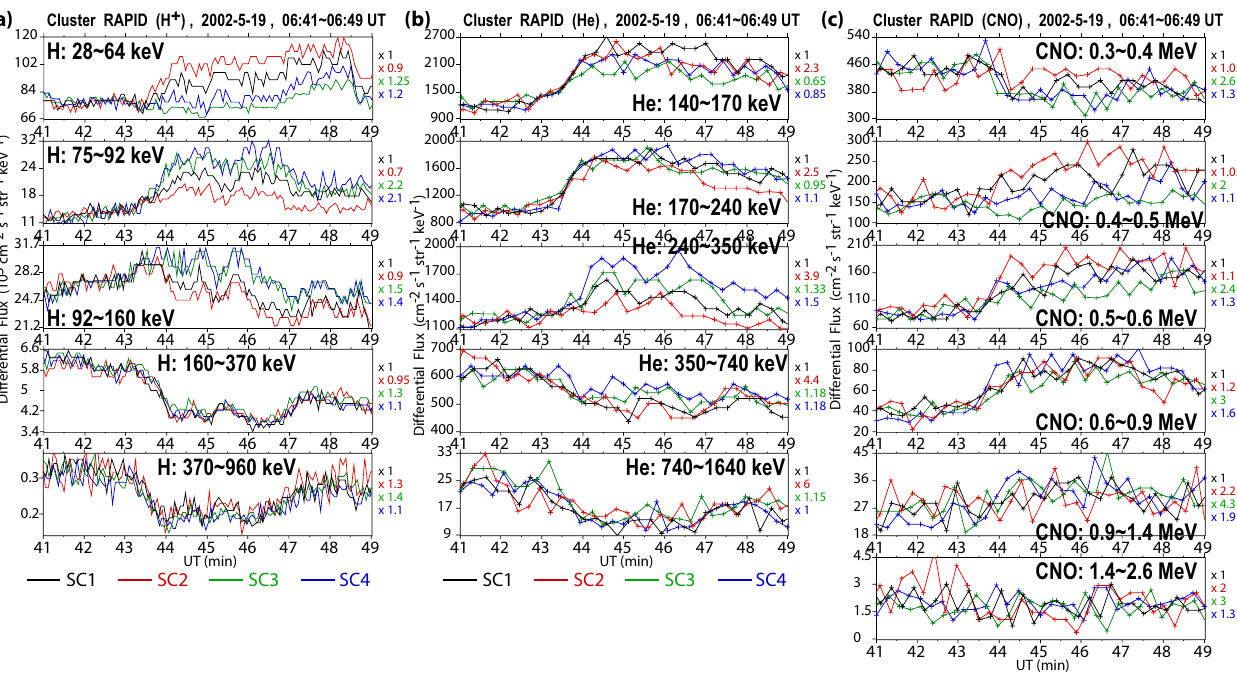
Fig. 9. Overplots of 4 π -averaged differential ion fluxes observed by RAPID from four spacecraft during 8-min period (06:41:00 ∼ 06:49:00UT). Only the relevant energies are listed. The data (black lines for SC-1, red lines for SC-2, green lines for SC-3, and blue lines for SC-4) are adjusted using scaling factors given in the right side of each panel. These factors are determined from the data before 06:43UT when all SC are assumed to detect the same flux value. The factors are not unity although we used the calibrated data. The CNO channel covers mass range of C, N, O, but we can generally ignore contributions from C and N in the